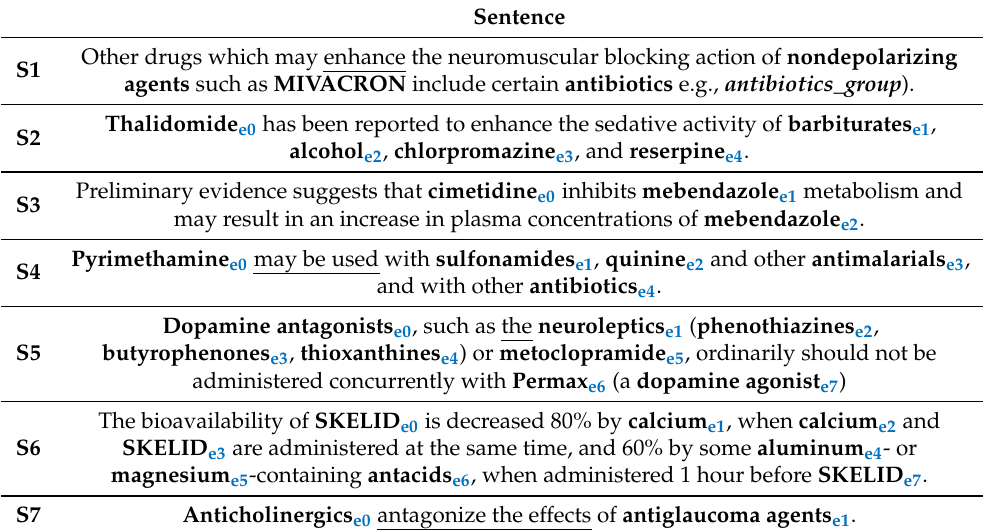
Table 4. Indicative cases of misclassified instances. Drug names are denoted in bold and underlined words describe the interaction in the sentence. Subscripts denote the drug name (entity) index in the